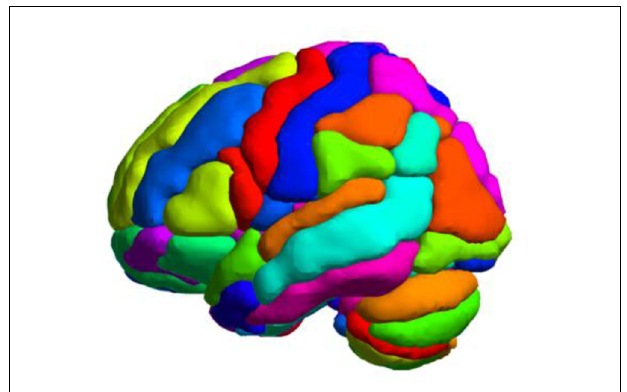
FIGURE 1 | Whole-brain parcellation with the Automated Anatomical Labeling (AAL) 116 template.